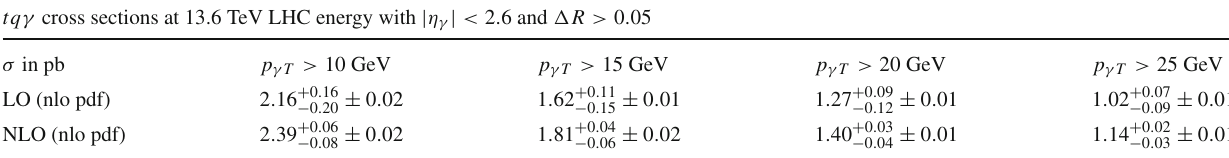
√ S = 13 . 6 TeV, with m t = 172 . 5 GeV and MSHT20 NLO pdf